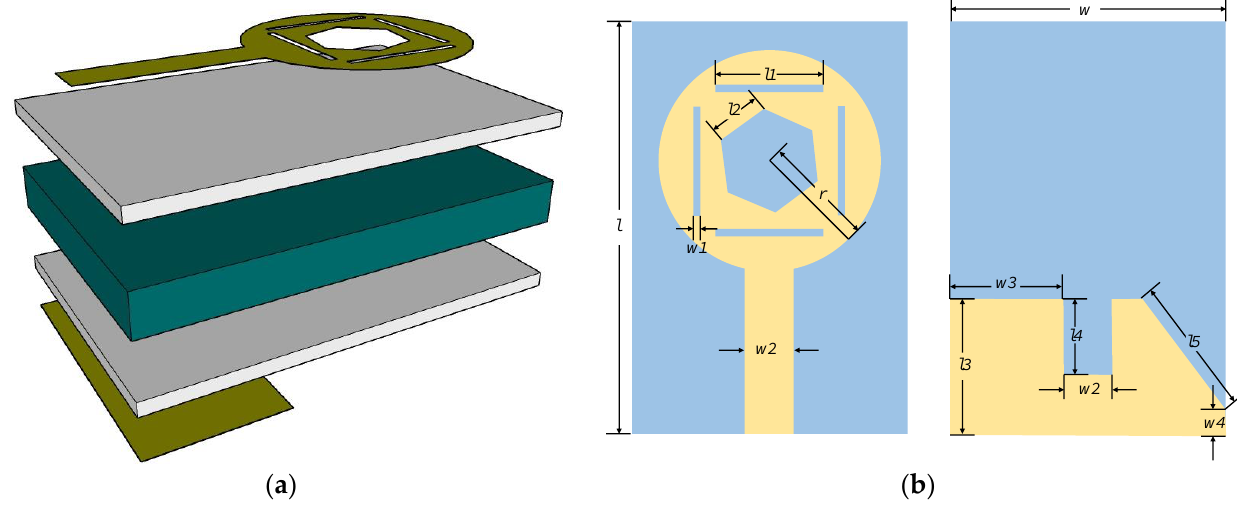
Figure 3. ( a ) Exploded view and ( b ) dimension parameters of the proposed antenna.